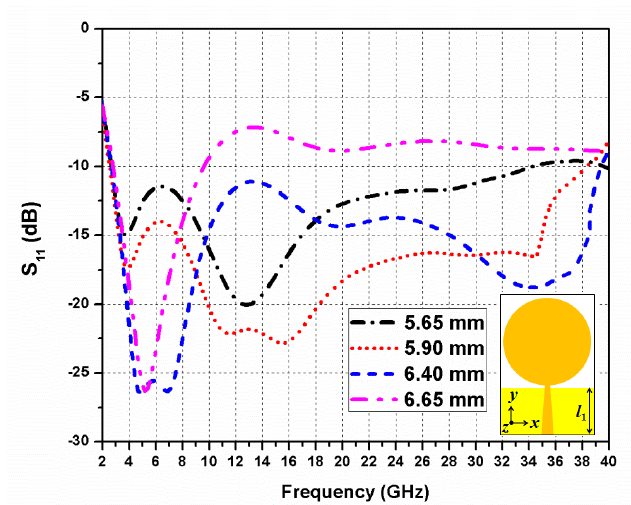
Figure 6. Simulated reflection coefficients of the antenna when the ground plane length ( l 1 ) is varied. To study further the behavior of the notch bands, a parametric analysis on the length of the U- shaped slots, meandered slot, and SRR is performed, as illustrated in Figure 7. In Figure 7a, the changes of the reflection coefficients as varying the SRR length ( b 1 ) are shown. It is noticed that as the value of b 1 increases, the notch band moves towards the lower frequency side. Whereas, when the length of the SRR is decreased, the notch band shifts towards the higher frequency side.